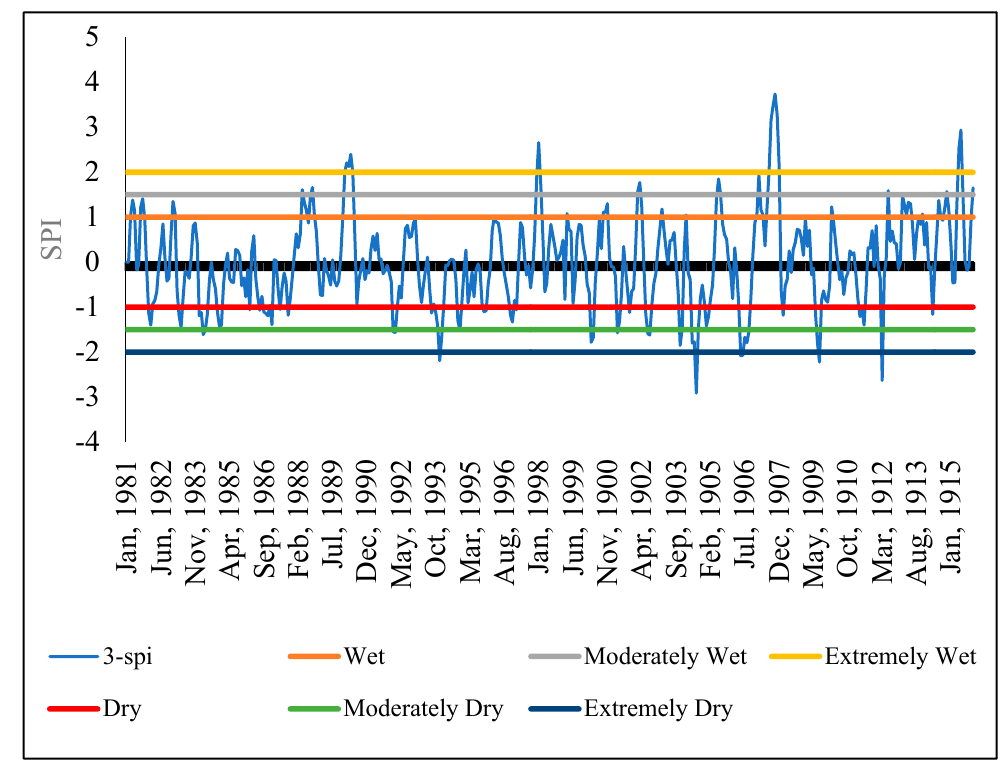
Figure 5. Three-month SPI over Sipi sub-catchment (1981–2015).